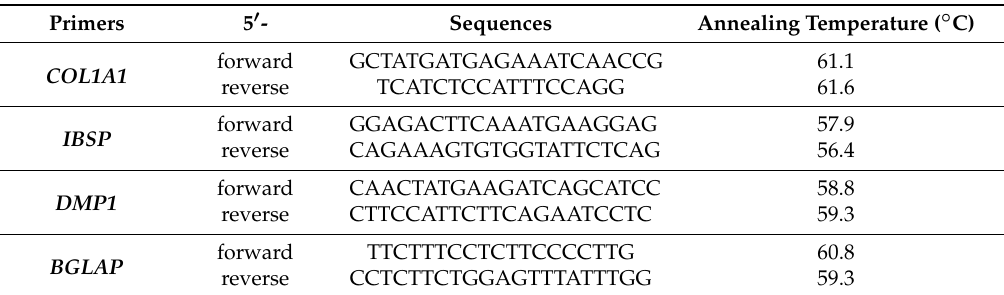
Table 1. Human primer sequences used for determination of gene expression levels by reverse transcription-polymerase chain reaction